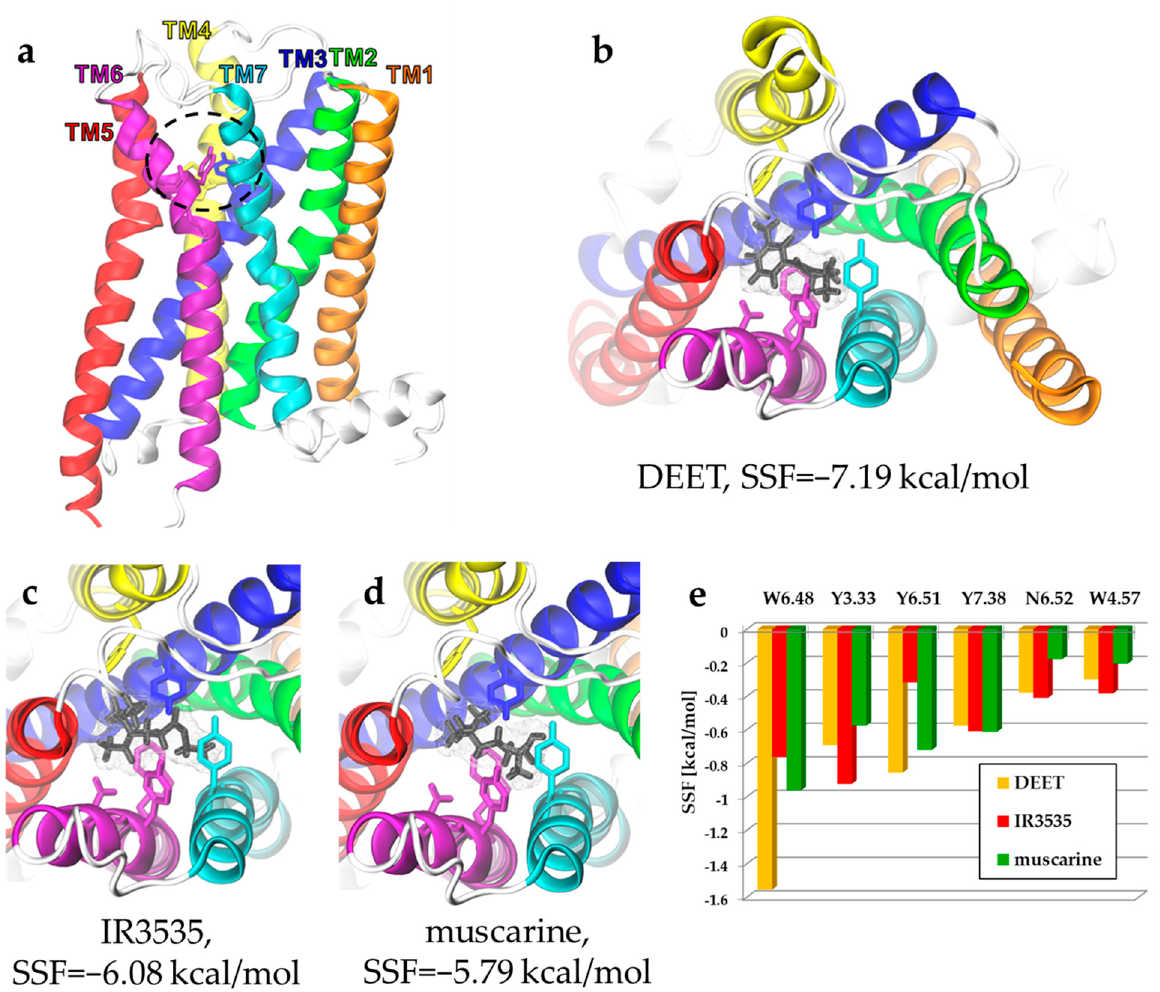
Figure 2. ( a ) The homology model of Drosophila melanogaster mAChR-A receptor based on the UniProtKB P16395 (ACM1_DROME) sequence and human M1 structure template (PDB code: 5CXV). The orthosteric binding-site region is marked with a black dashed line. ( b – e ) SMINA molecular docking of insect repellents DEET ( b ) and IR3535 ( c ) and classical agonist muscarine ( d ) to the homology model shown in ( a ). Top views are presented. ( e ) Docking energy decomposition presented as SMINA scoring function (SSF) in kcal/mol shows interacting ligand residues of the mAChR-A orthosteric binding site.